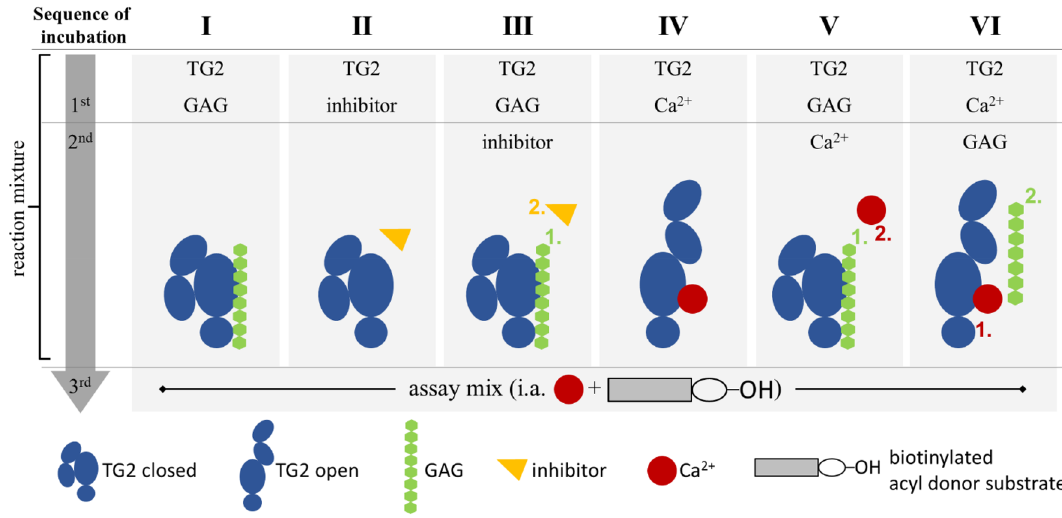
Figure 5. Experimental setup of TG2 enzyme activity assay. For crosslinking activity determination of TG2 orthologues a colorimetric activity assay kit (CS1070, Sigma Aldrich) was used. By varying the incubation